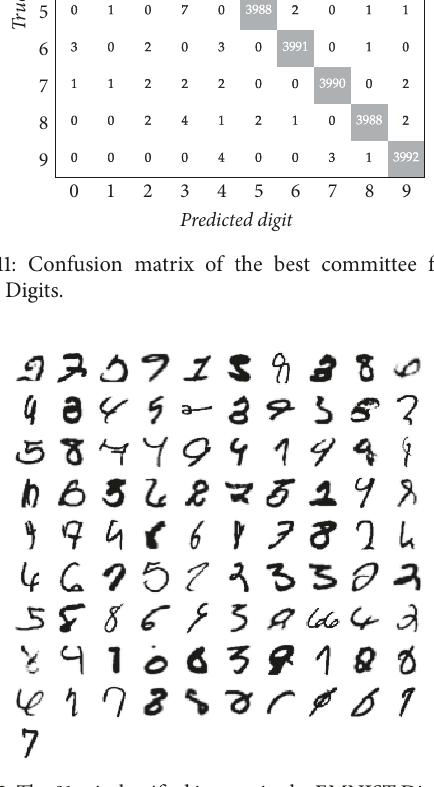
Figure 12: The 91 misclassified images in the EMNIST Digits test set with the best committee